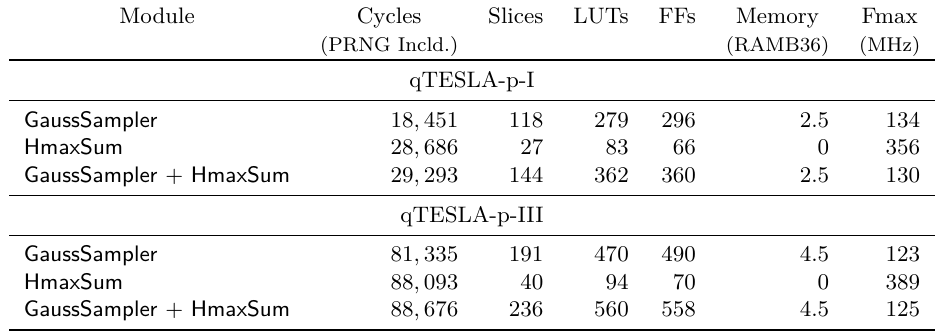
Table 7: Performance of the GaussSampler , HmaxSum , and GaussSampler + HmaxSum hardware modules; the last combination of modules gives the best performance due to parallelized